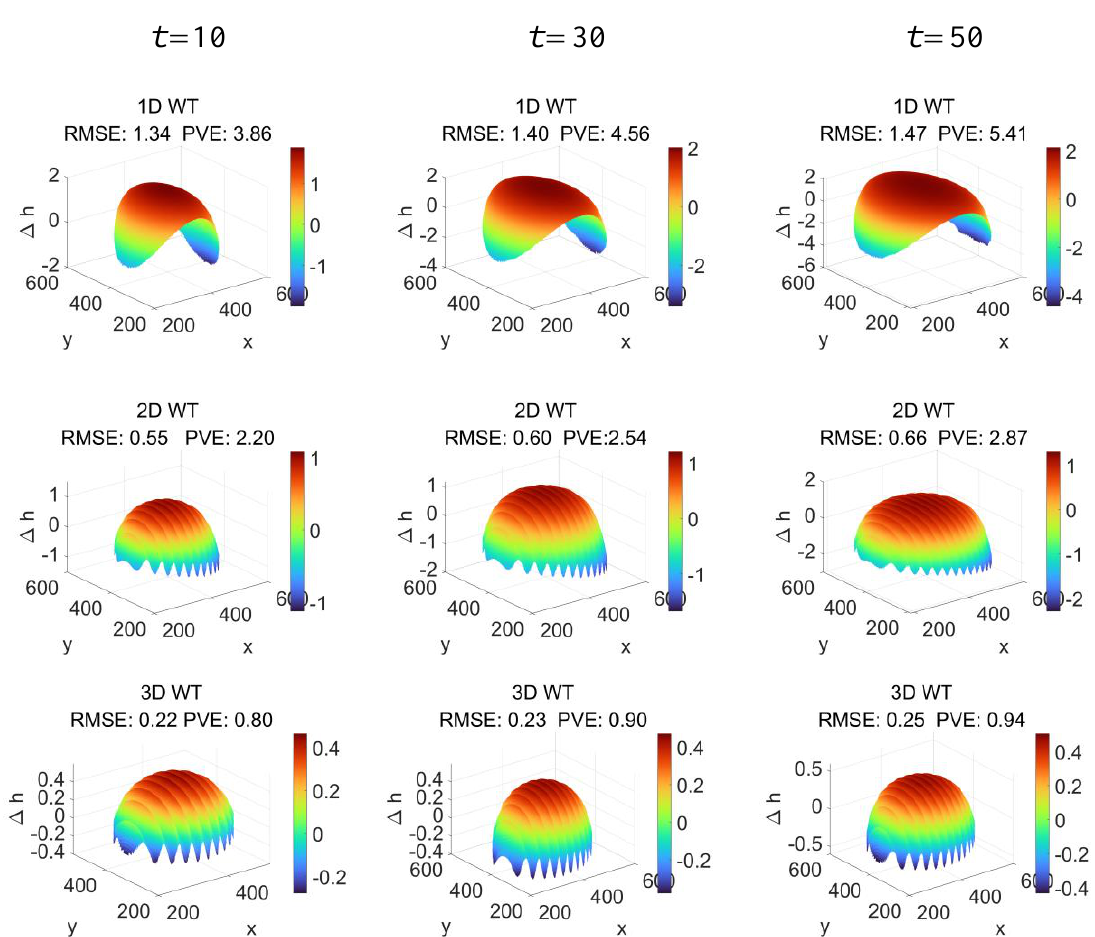
Figure 4. Spherical crown reconstruction error with different method.